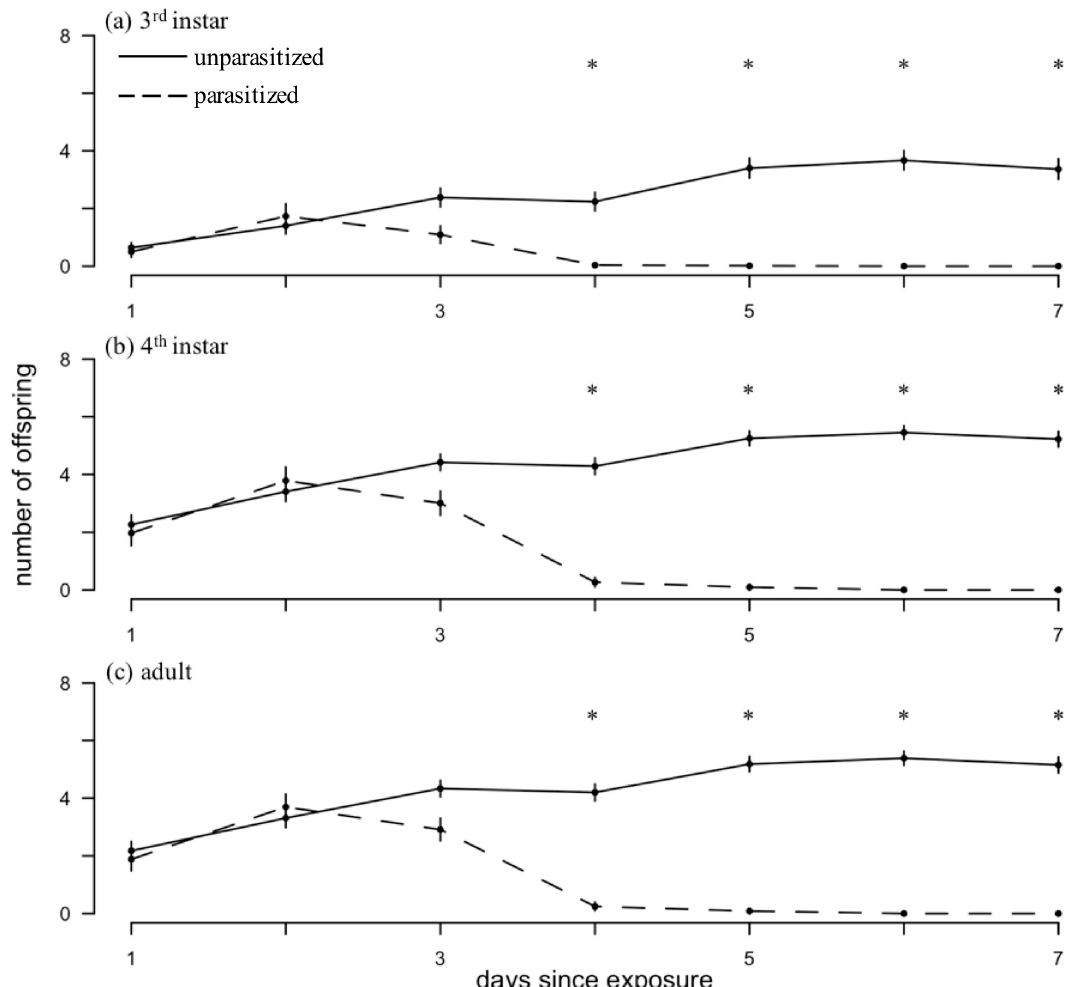
Fig 2. Daily reproduction of parasitized and unparasitized soybean aphids. (a) 3 rd stadium, (b) 4 th stadium, and (c) adult. Points plot least square means ± SE. Solid lines: unparasitized (control) aphids; dashed lines: parasitized aphids. Asterisks indicate significant differences between control and parasitized aphid reproduction on each day following parasitoid exposure (adjusted for multiple comparisons).